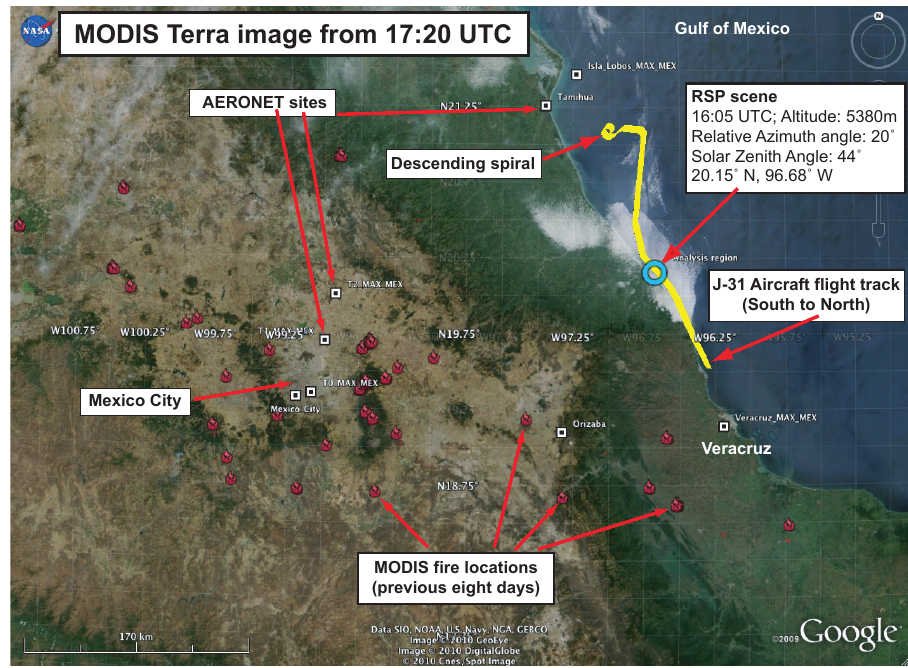
Fig. 2. The spatial context of our AAC scene is presented in this figure. The blue circle indicates the location of RSP observations, above a marine stratocumulus cloud on the Gulf of Mexico coast. A portion of the J-31 flight track is shown in yellow. The J-31 performed a spiral to the surface about 125km northwest of the scene, and data collected during this descent provided information about cloud and aerosol vertical distribution. Aerosol sources include urban/industrial emissions in the Mexico City Metropolitan Area (MCMA) basin, a high valley to the west, and numerous (mostly agricultural) fires indicated by the red fire icons. Fire locations were identified by the MODIS active fire product and represent fires within the previous eight days. The MODIS Terra instrument captured the underlying image about an hour and fifteen minutes after our scene was